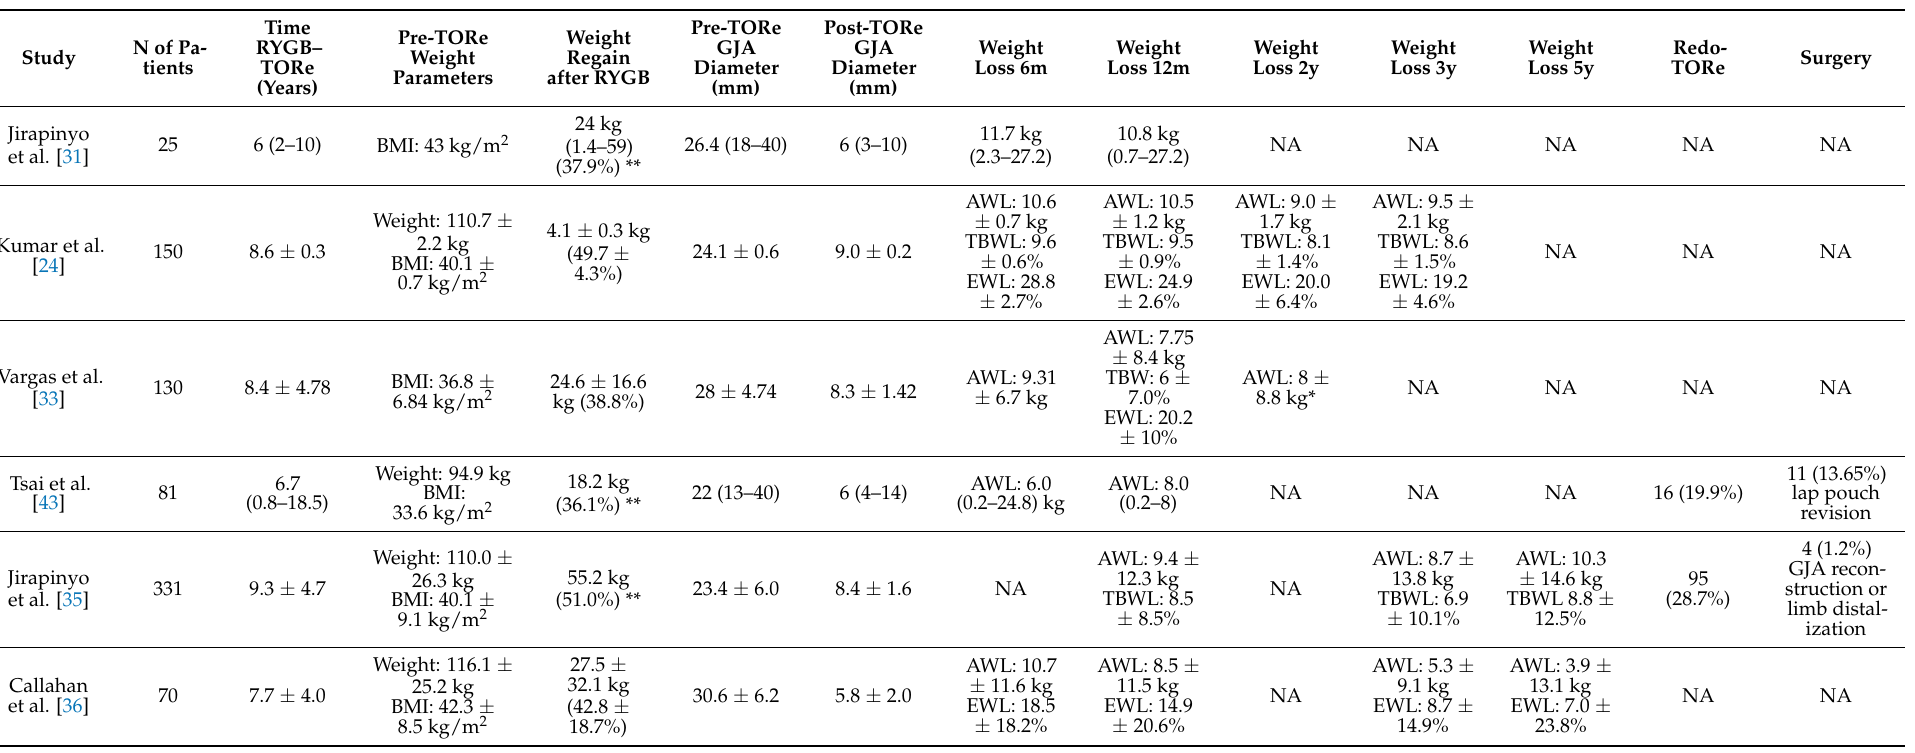
Table 1. Summary of the main studies evaluating traditional full-thickness TORe (APC-Apollo Overstitch) for weight regain after gastric